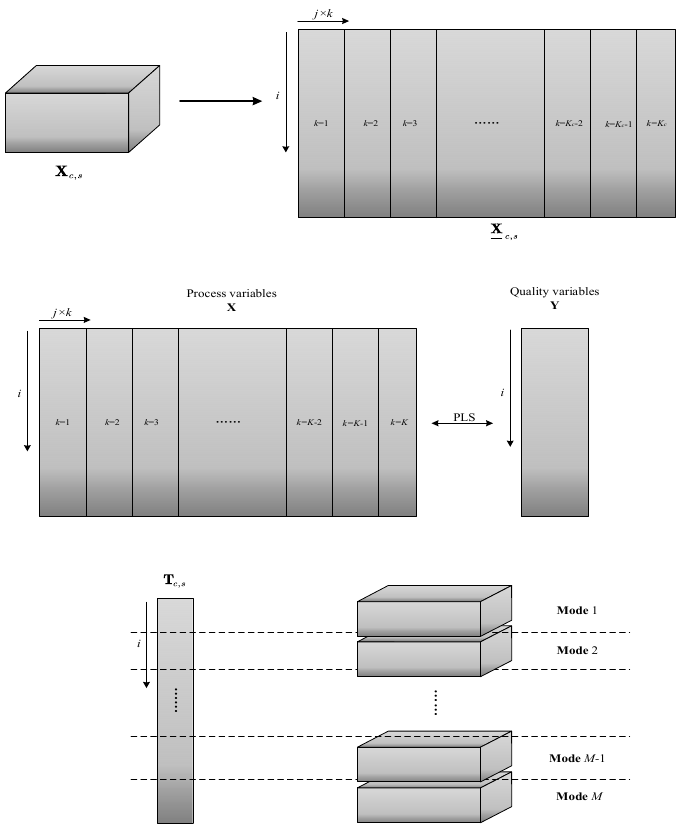
Figure 3. Mode division strategy in batch direction.